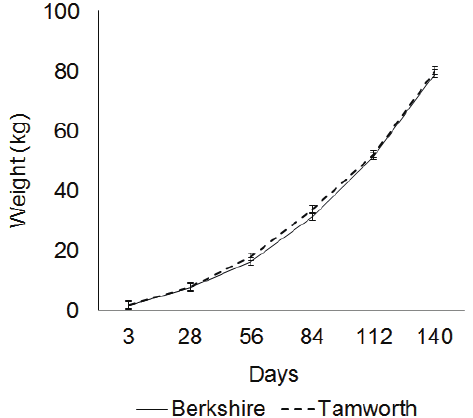
Figure 1. Least square means and standard errors of body weights of Berkshire pigs sired by Berkshire and Tamworth.